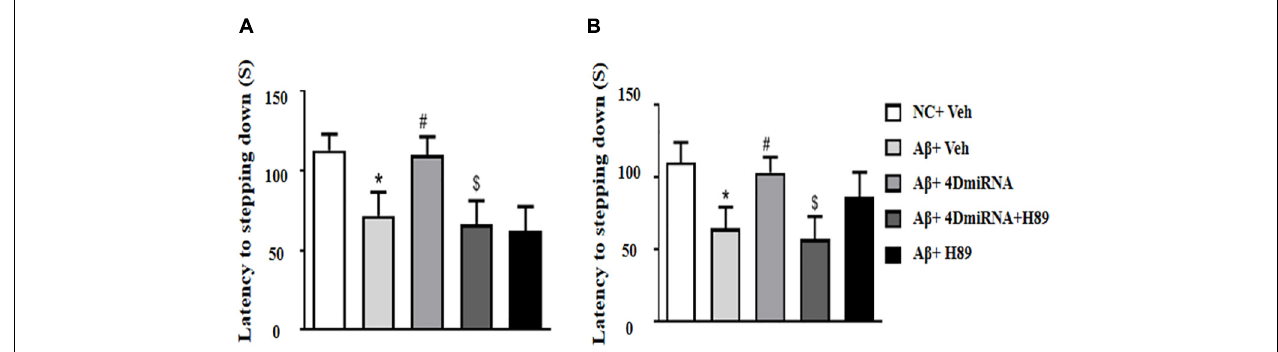
FIGURE 3 | PDE4D deficiency improved memory in the step-down passive avoidance test in A β 1–42-treated mice. The latency to jump down to the floor 3 h (A) and 24 h (B) after the training session was recorded after microinjection of lenti-PDE4D-miRNA into the prefrontal cortex. Values were the means ± SEM with 12 mice in each group. * P < 0.05 vs. control group (NC); # P < 0.05 vs. A β +Veh group; $ P < 0.05 vs. A β +4DmiRNA group.